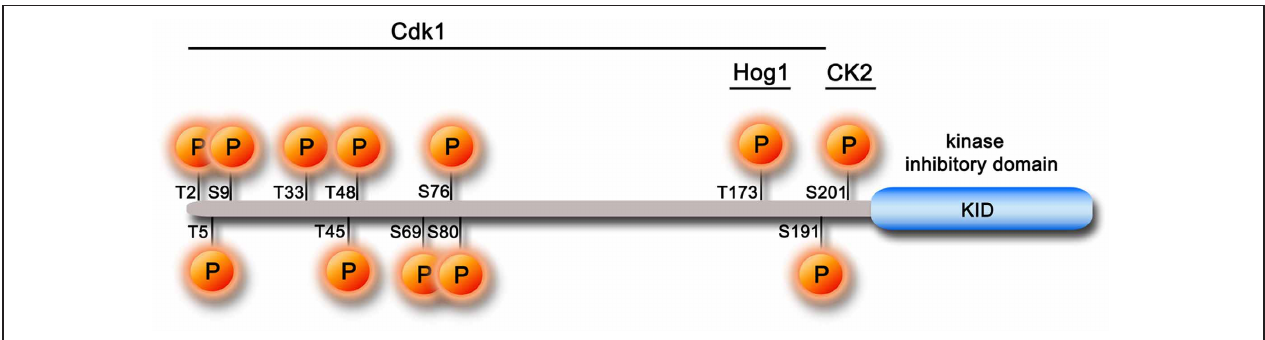
FIGURE 1 | Schematic representation of the full-length Sic1 protein and its principal phosphorylation sites. The minimal functional KID fragment, corresponding to the last 70 residues of the protein, is